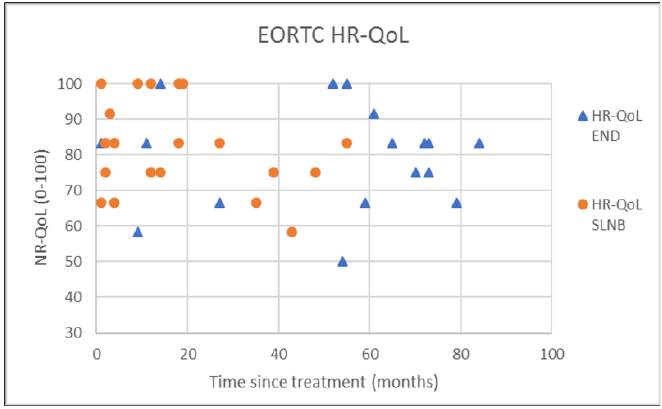
Figure 5. EORTC HR-QoL C30 in relation to time since treatment.